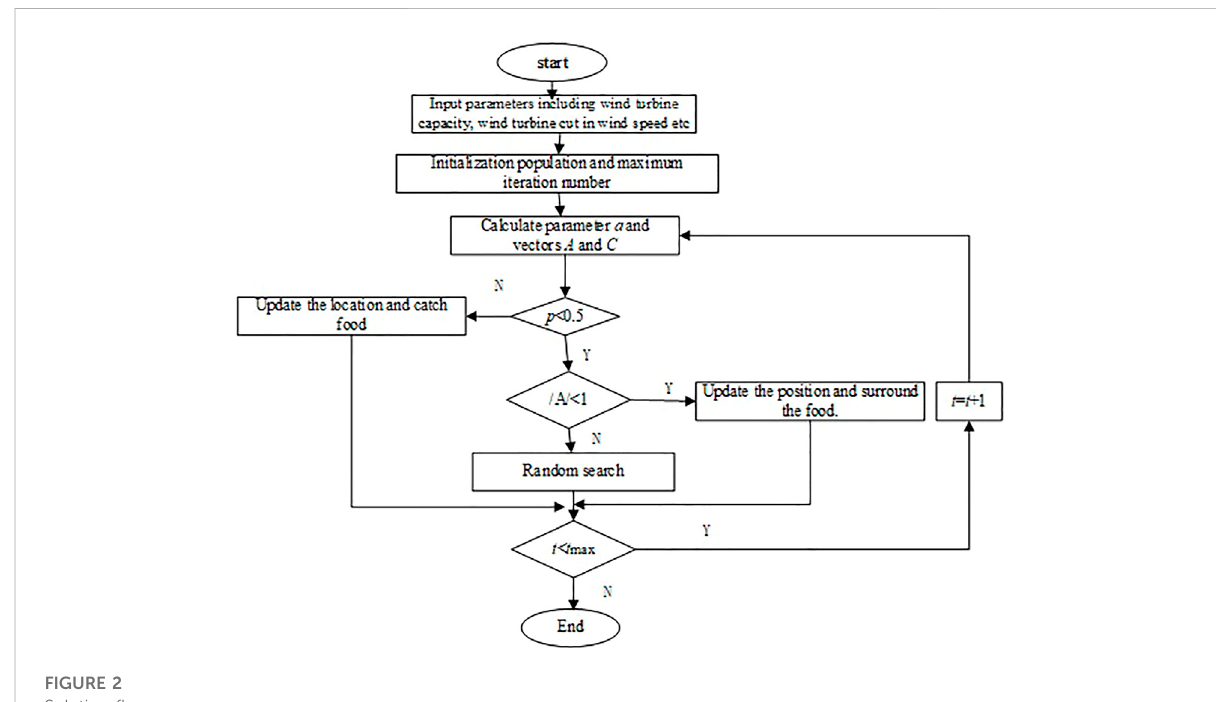
FIGURE 2 Solution fl ow.